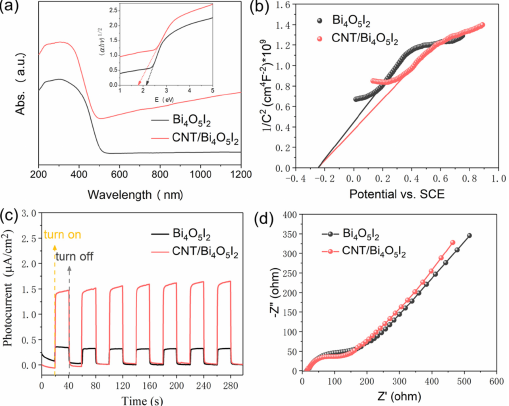
Figure 6. ( a ) UV-vis diffuse reflectance absorption (DRS) spectra of pure Bi 4 O 5 I 2 and CNT/Bi 4 O 5 I 2 (inset: estimated band gaps of pure Bi 4 O 5 I 2 and CNT/Bi 4 O 5 I 2 , respectively); ( b ) Mott–Schottky (M-S) plots, ( c ) transient photocurrent density, ( d ) electrochemical impedance spectroscopy of Bi 4 O 5 I 2 and CNT/Bi 4 O 5 I 2 .